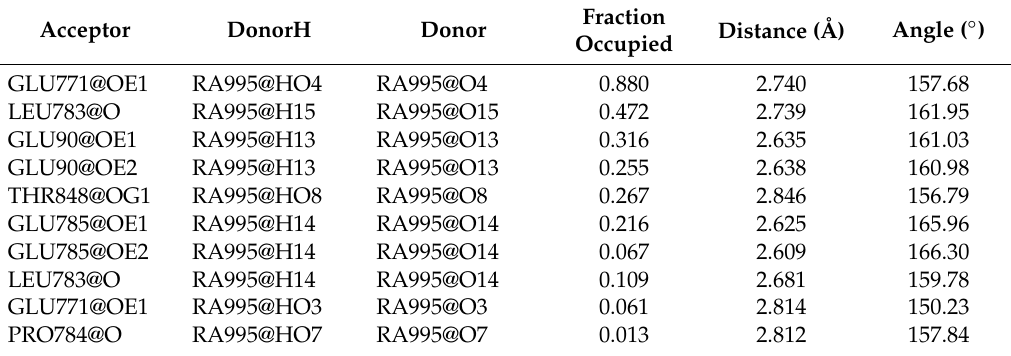
Table 1. Hydrogen bonds analysis for the sarco / endoplasmic reticulum Ca 2 + -ATPase 1a–rutin arachidonate (SERCA1a-RA) complex (last 100ns).